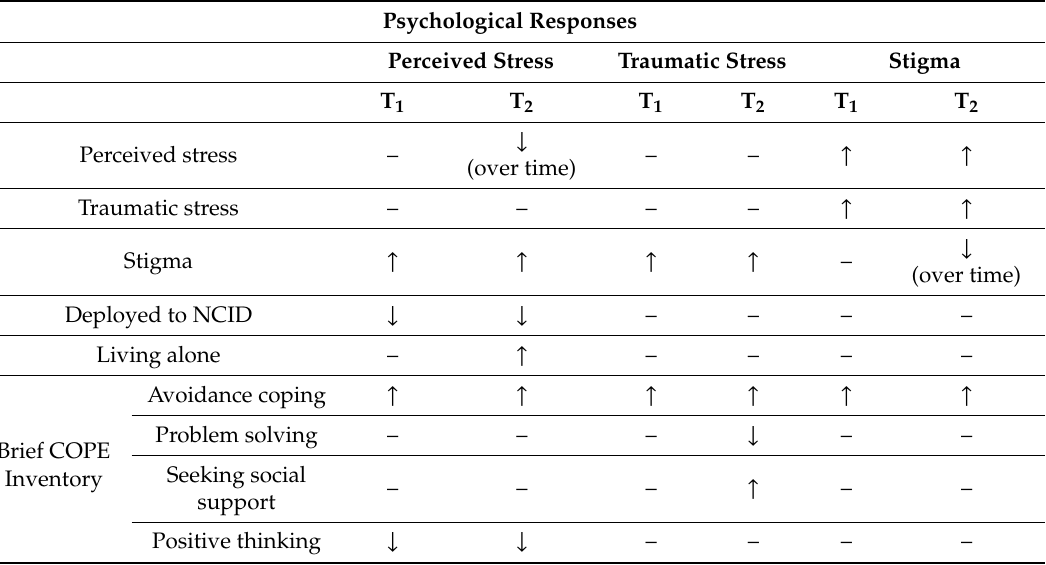
Table 4. Summary of findings across both